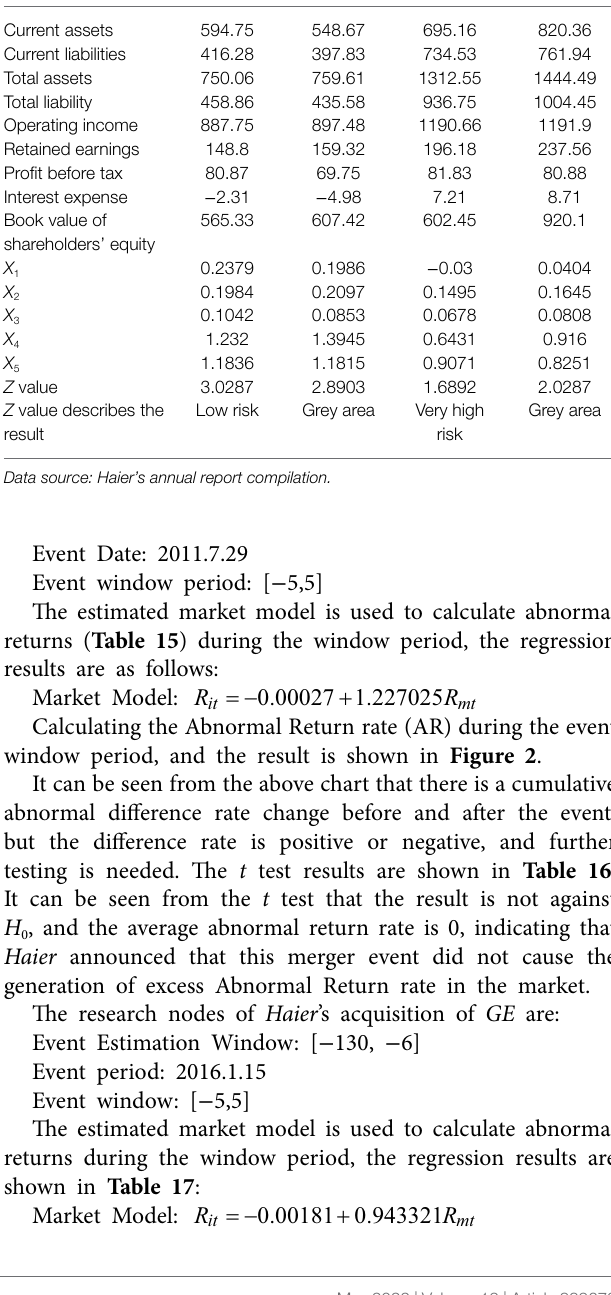
TABLE 13 | Judgment standard of Z value and company risk. Z score Probability of bankruptcy in the short term <1.8